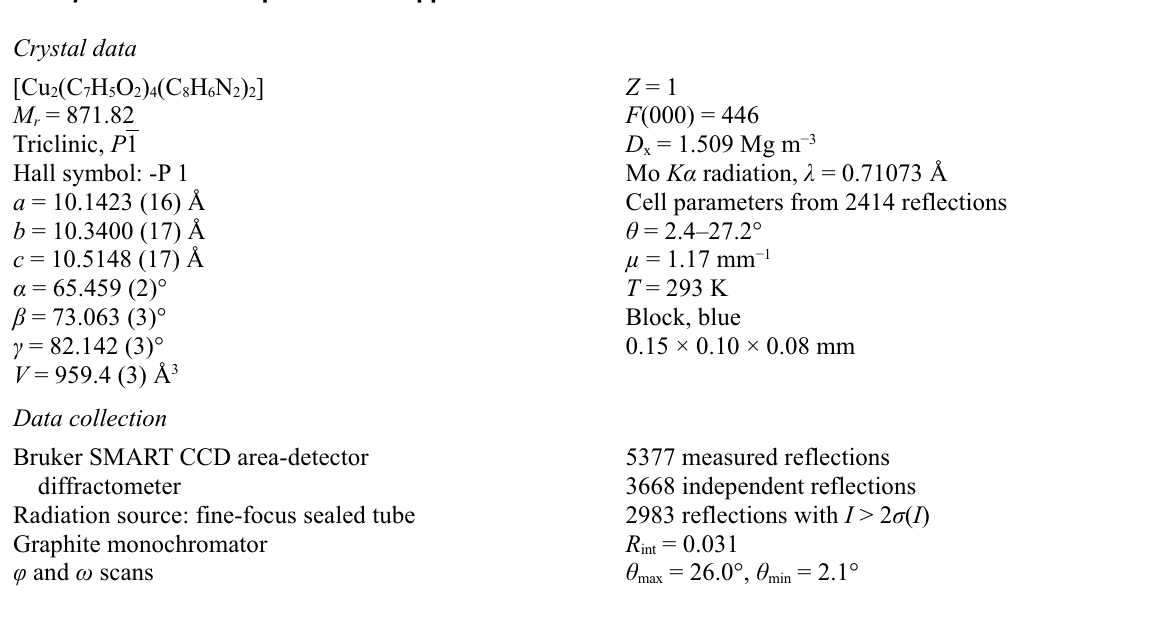
sup-2 Acta Cryst. (2008). E 64 , m286